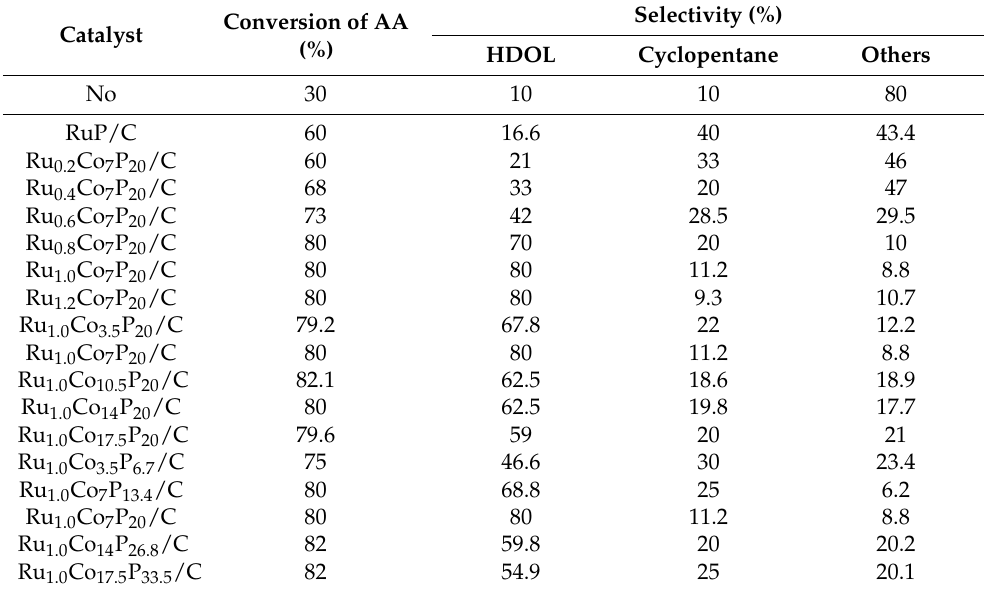
Table 1. The conversion of AA and selectivity to HDOL on the as-prepared